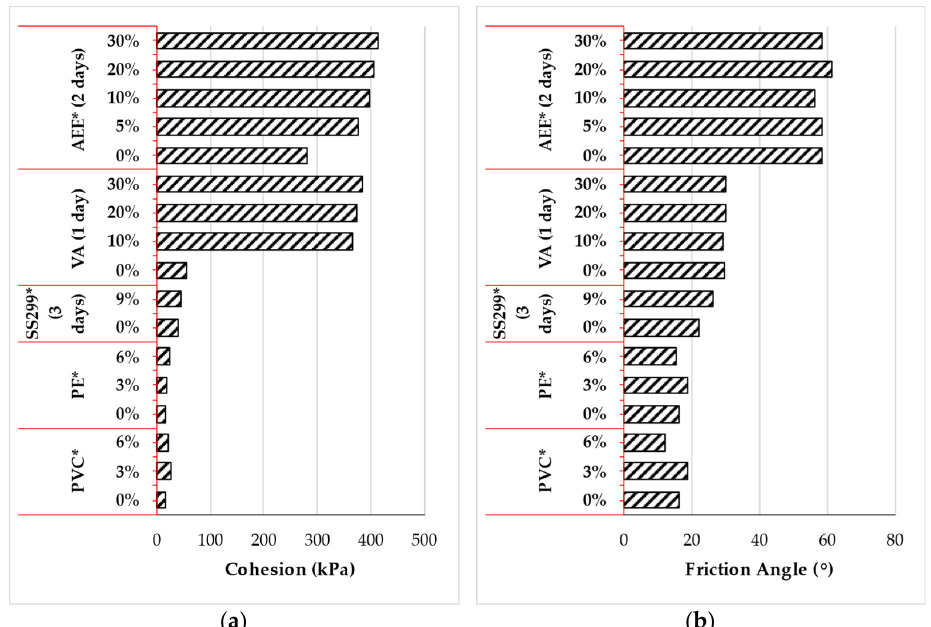
Figure 7. Variation in the shear strength parameter of fine-grain soil with polymer concentration: ( a ) Cohesion; ( b ) Frictional angle (* indicates polymer concentration as a % of dry weight of soil). Note: these figures were created with data obtained from